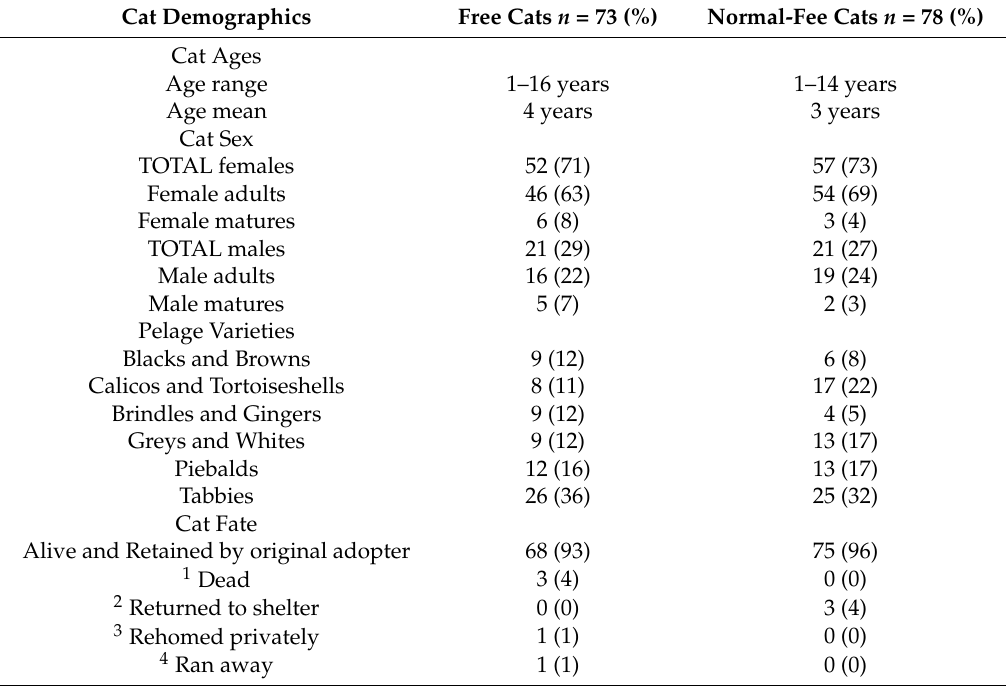
Table 1. Demographics of 73 free cats adopted (4 pairs) and 78 normal-fee cats (6 pairs) adopted